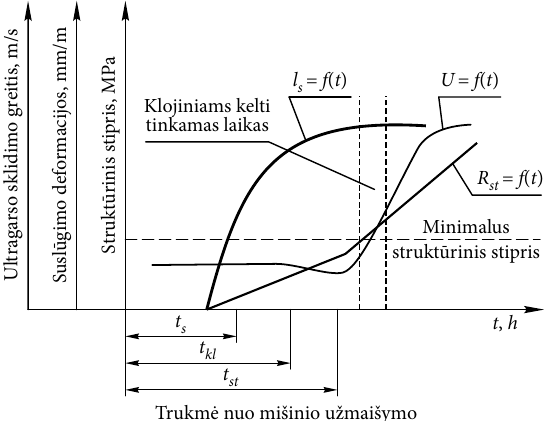
Fig. 5. Interaction of parameters governing concreting